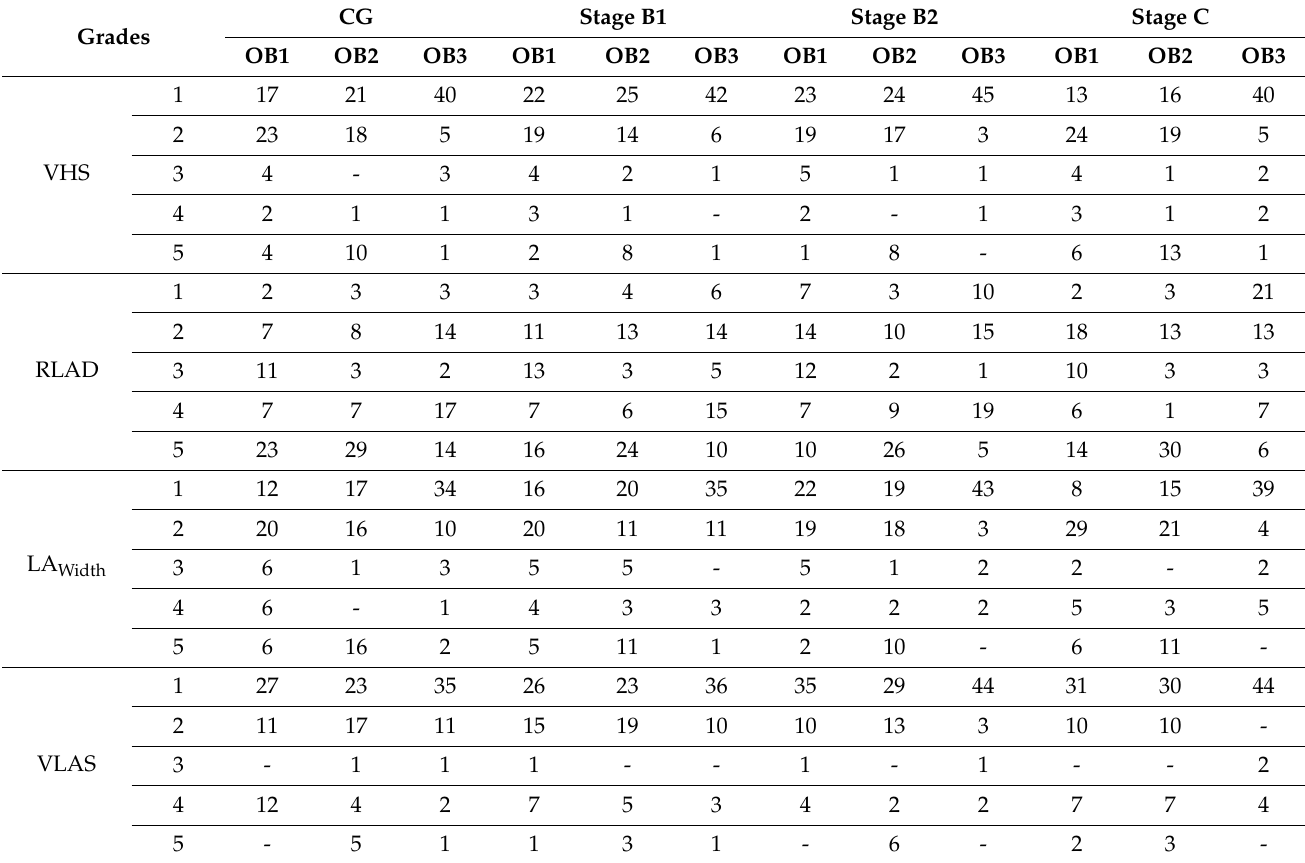
Table 4. Grading of each measurement in conventional